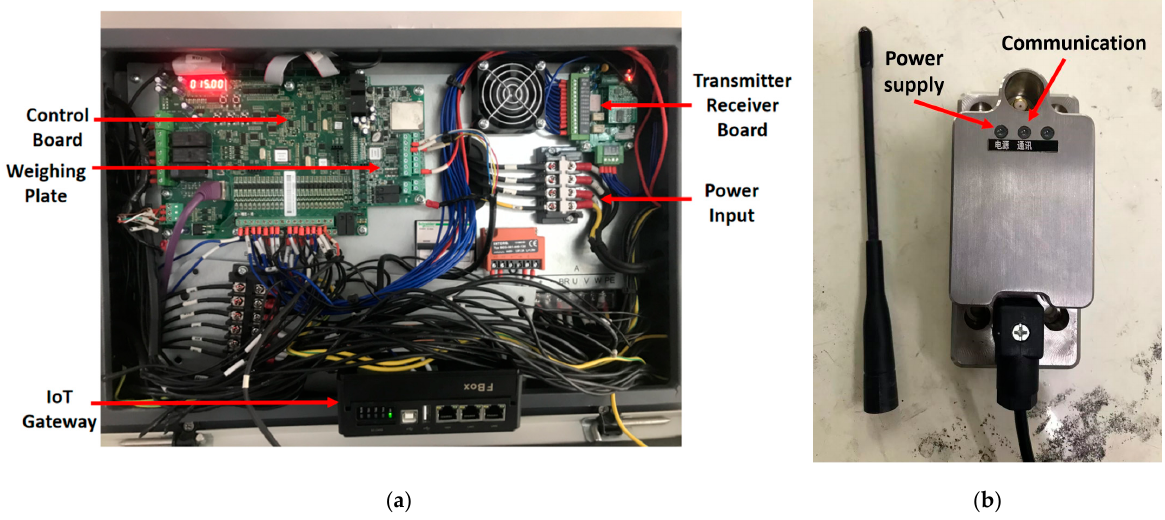
Figure 10. The IoT gateway communication settings. ( a ) The location of the IoT gateway box in the bridge-crane distribution box. ( b ) The com terminal transmitter.